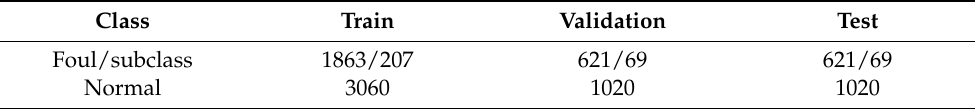
Table 1. Original data sample distributions of all classes.